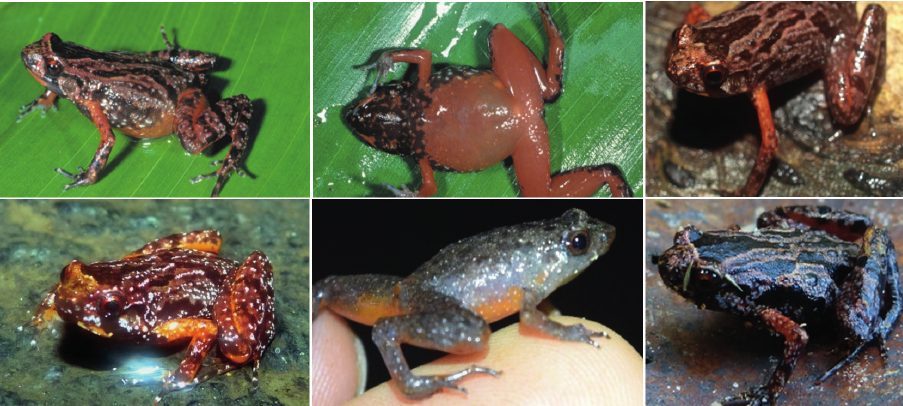
Figure 8. Images of Stumpffia kibomena (top row from the species description of Glaw et al. (2015) and the bottom row from inaturalist.org taken by Leonard Bolte and Jordan Broadhead, used with permis- sion). Note the red marking on the lower lips and the red arms which differ from S. lynnae sp. nov .